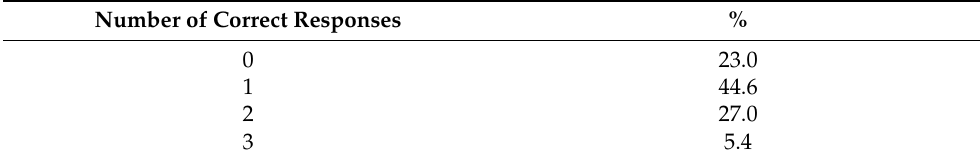
Table 4. Percentage of total correct